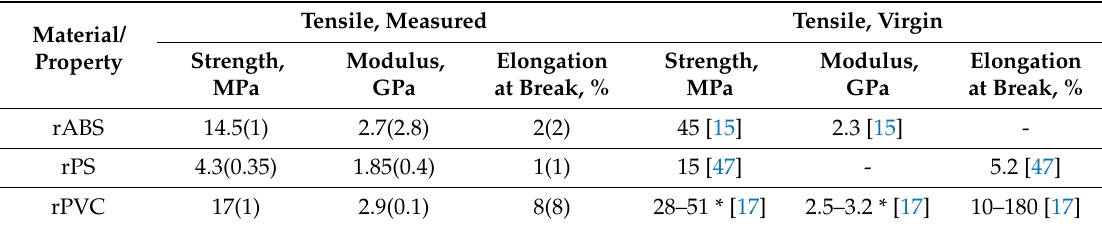
Table 4. Tensile properties of extruded filaments from recycled materials and virgin counterparts taken from internet